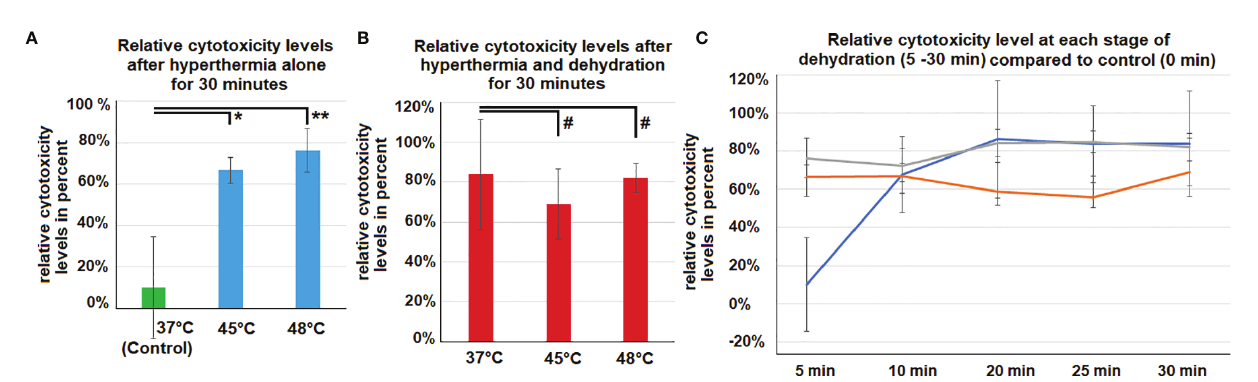
FIGURE 4 | (A) In vitro cytotoxicity on colon cancer cells after 30 minutes of hyperthermia exposure (without dehydration) at 45°C and 48°C. Control cells were only exposed to the physiological temperature of 37°C. (B) In vitro cytotoxicity on colon cancer cells after 30 minutes of hyperthermia exposure and dehydration at 37°,